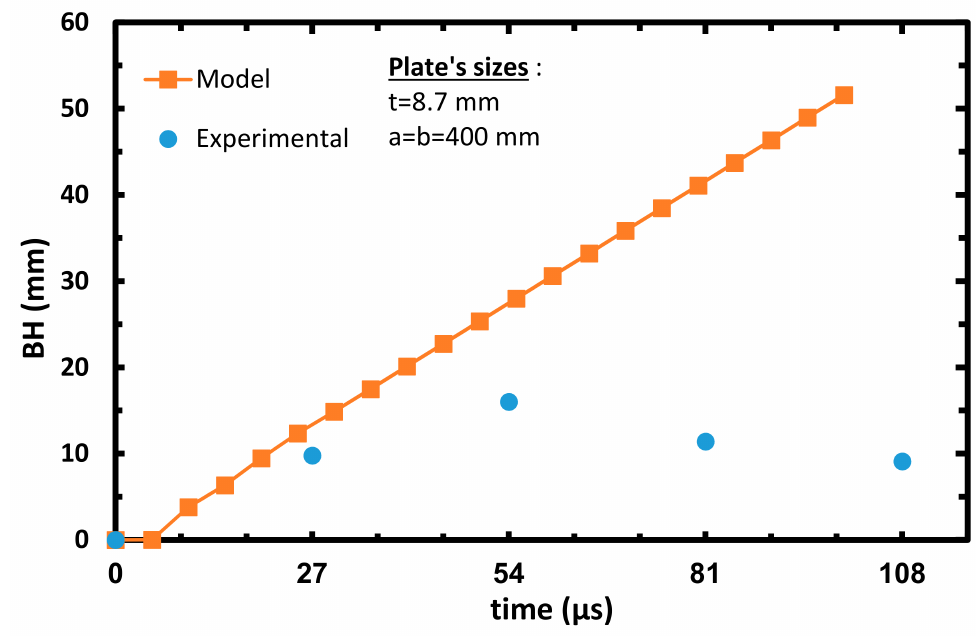
Figure 20. Plate’s bulge height vs. time of the calibrated model, Vinitial = 893